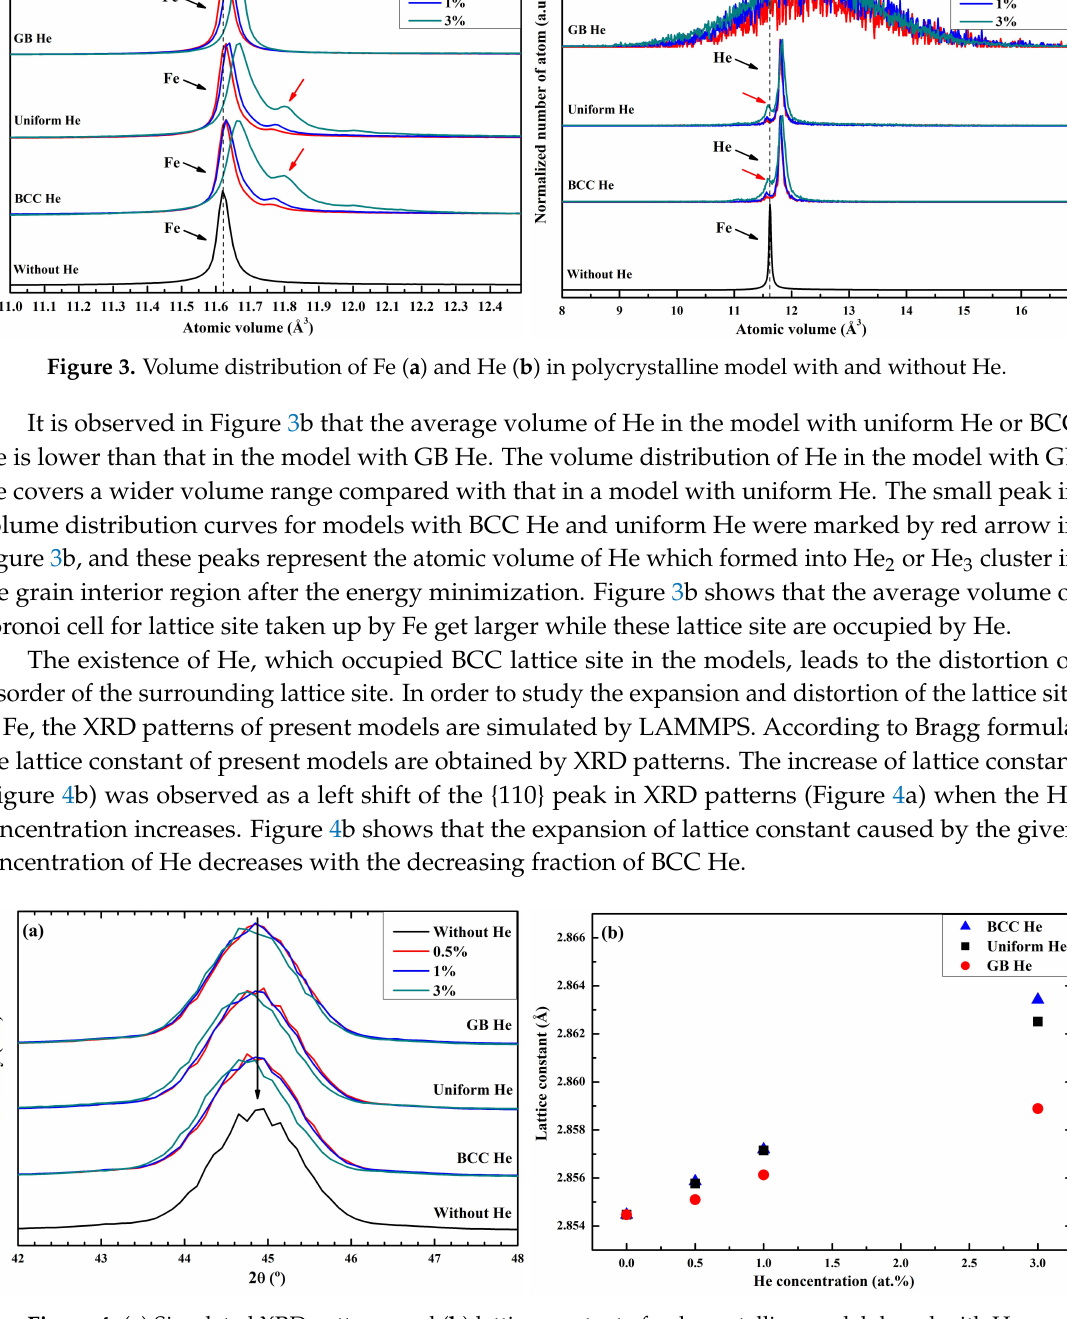
Figure 4. ( a ) Simulated XRD patterns and ( b ) lattice constant of polycrystalline model doped with